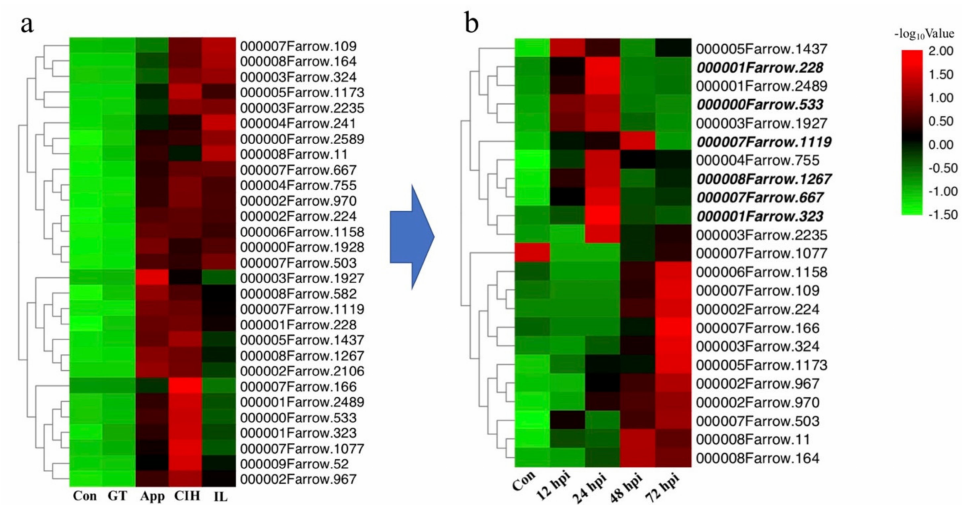
Figure 6. Expression analysis of candidate e ff ector proteins (CEPs). ( a ) Heat map of CEPs of C. camelliae based on the FPKM (Fragments Per Kilobase of transcript sequence per Millions base pairs sequenced). ( b ) Heat map of CEPs based on qRT-PCR assay in vivo. Color scale was provided for two figures. (Con: conidiun; GT: germ tube; app: appressoria; CIH: cellophane infectious hyphae; IL: infection leaves; hpi: hours